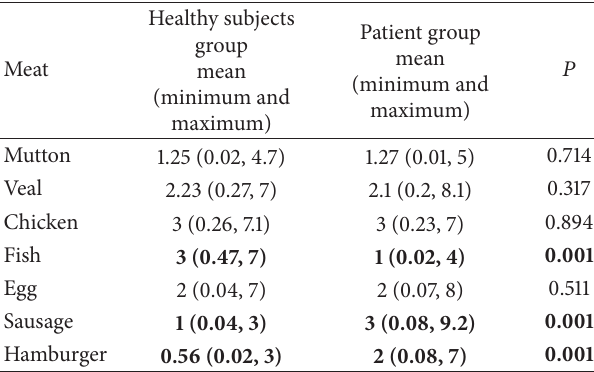
Table 2: Food frequency data on meat samples from healthy group and patient group (per a